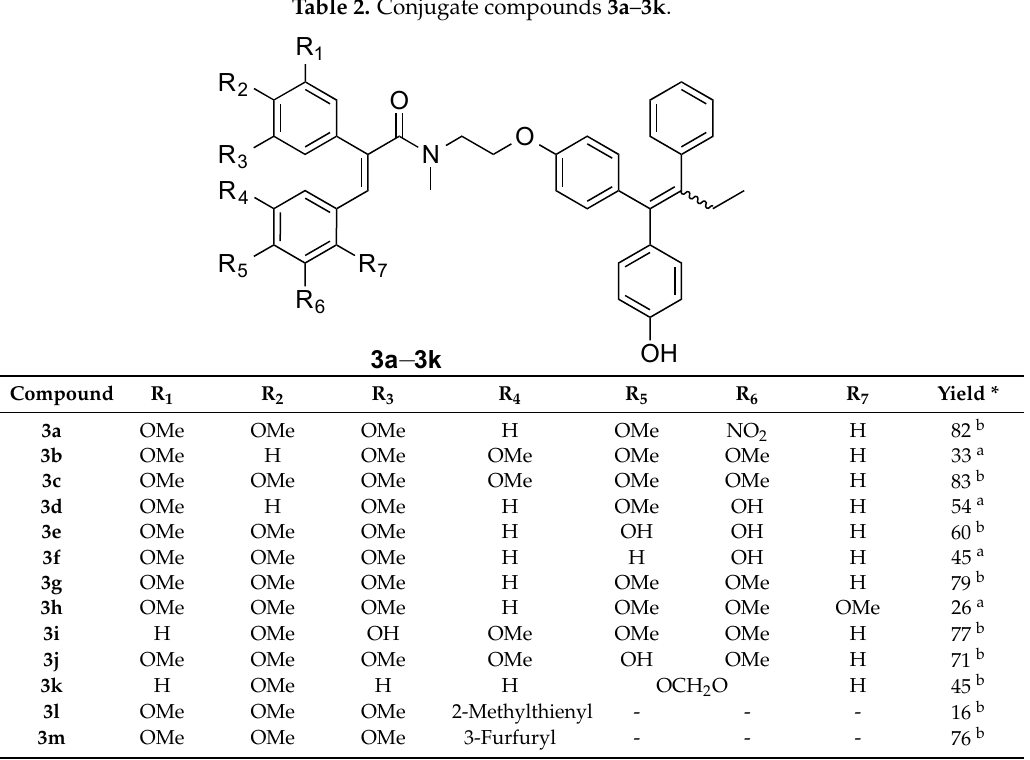
Table 2. Conjugate compounds 3a – 3k .